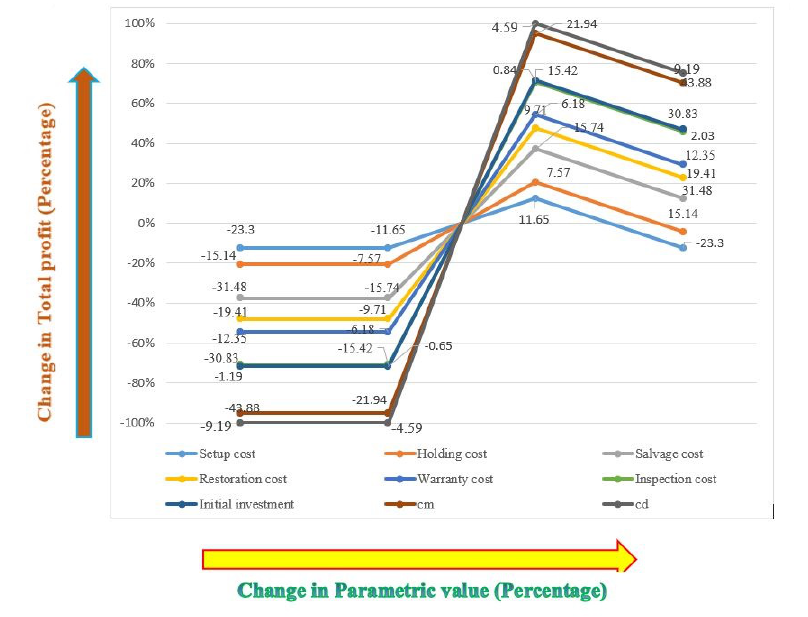
Figure 3. Effect of parametric values on expected total profit ETP ( T PR , M rp , η , U pr , F nf , S nf )